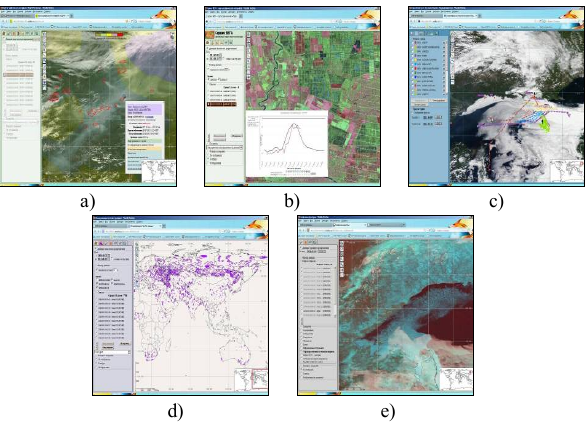
Fig. 7. Examples of interfaces of various monitoring systems based on GEOSMIS. a) FFA ISDM, b) satellite